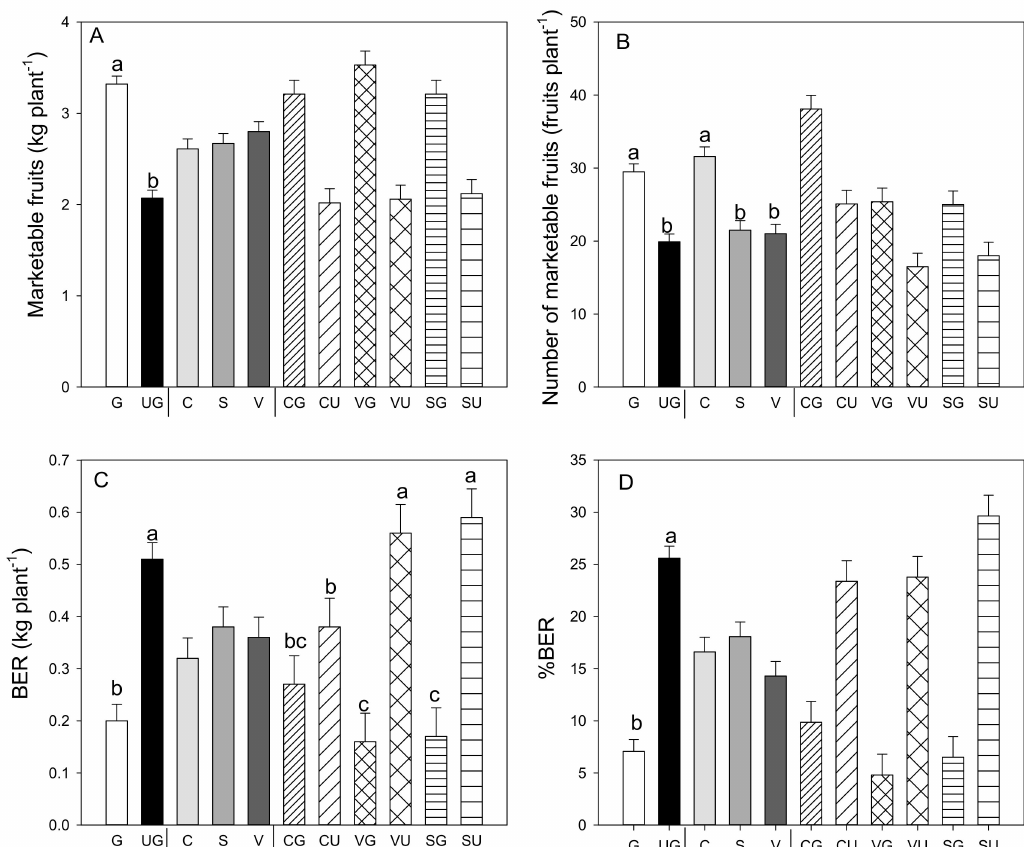
Figure 1. Marketable fruit yield ( A ), number of marketable fruits ( B ), production ( C ) and percentage ( D ) of fruit a ff ected by blossom-end rot (BER) in the three pepper landraces “Cuerno” (C), “Valencia” (V), and “Sueca” (S) grafted (G) or ungrafted (U) on rootstock F1 NIBER ® . Values are the mean ± SE of 15 plants per replicate (3 replicates) per landrace. Means were subjected to a two-way ANOVA with grafting and landrace as sources of variability. Di ff erent letters for the factors grafting and landrace, or their interaction, indicate significant di ff erences at p < 0.05 using the LSD test. No letter indicates the non-significance of the F